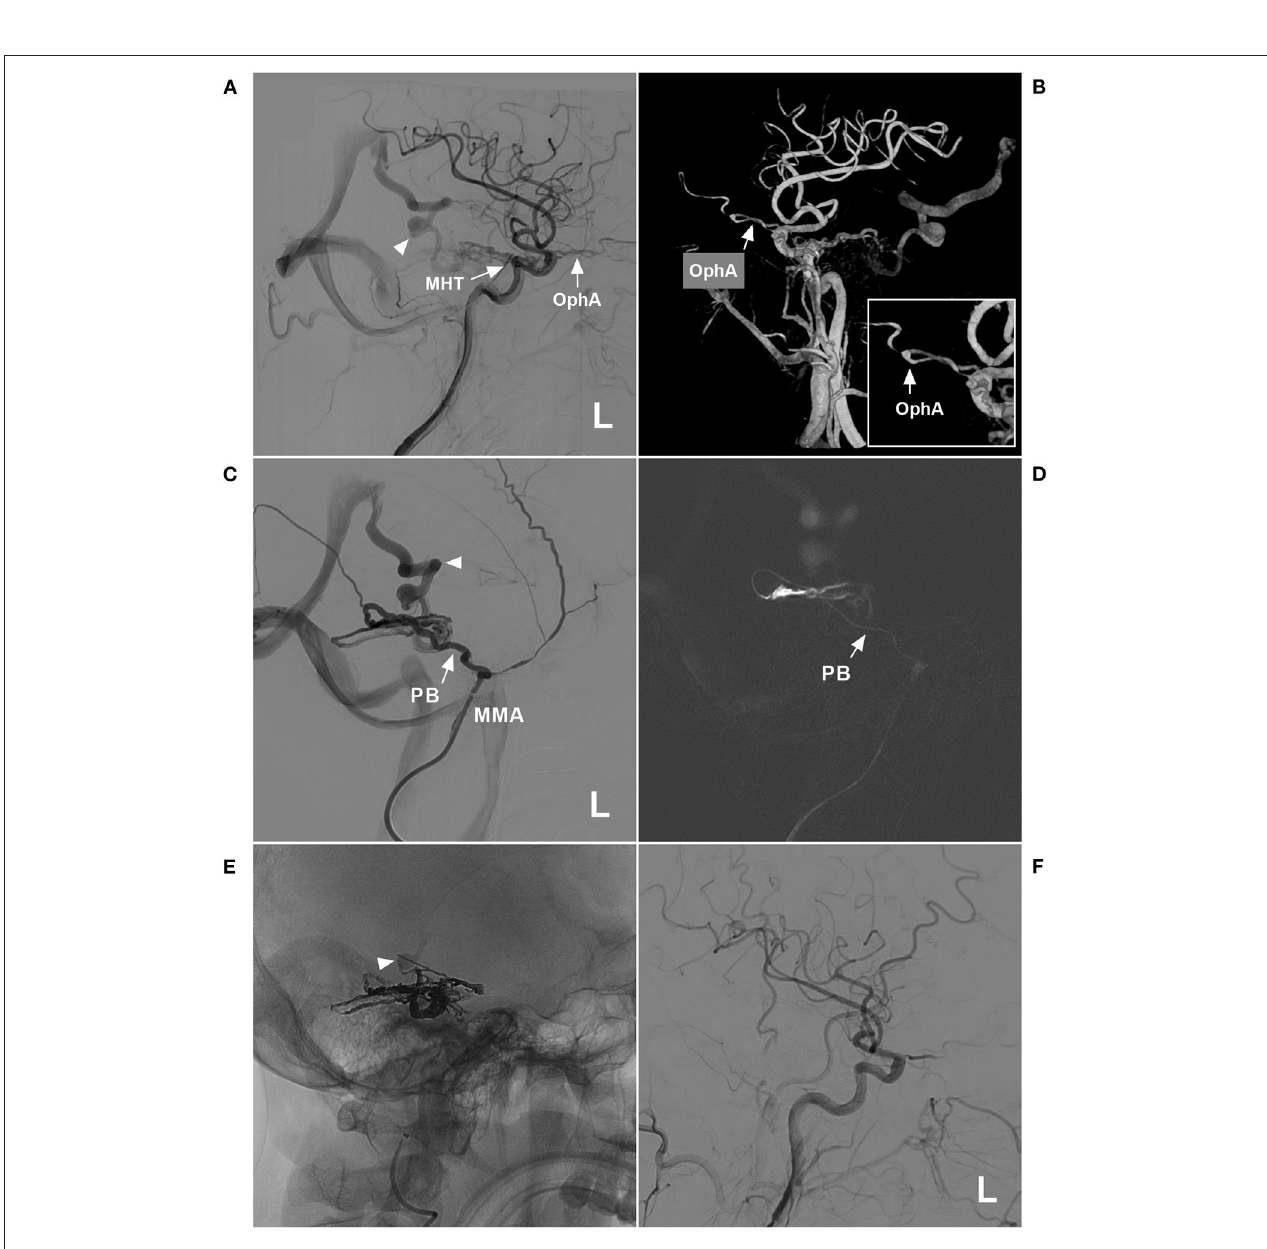
FIGURE 8 | Successful type IIIb EVT for a DAVF of the tentorium. (A) Lateral view DSA of the left carotid artery showed a DAVF supplied by the MHT and OphA (arrows) draining to the vein of Galen (triangle). (B) Three-dimensional DSA showed that the recurrent meningeal branch of the OphA supplied the DAVF (arrow). The inset in the lower right shows the magnified local OphA (arrow). (C) Left MMA angiography showed that the PB of the MMA supplied the DAVF. The triangle indicates deep vein drainage. (D) A roadmap image shows that the microcatheter passed through the PB (arrow) and into the fistula. (E) X-ray film showing the casting Onyx. Onyx penetrated the fistula and sealed the draining vein (triangle). (F) The left carotid artery showed that the EVT was complete. DAVF, dural arteriovenous fistula; DSA, digital subtraction angiography; EVT, endovascular treatment; L, left; MHT, meningohypophyseal trunk; MMA, middle meningeal artery; OphA, ophthalmic artery; PB, petrous